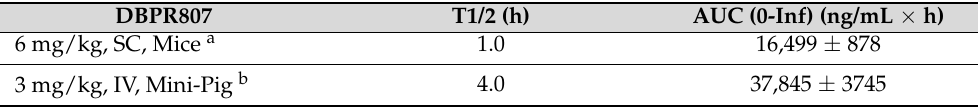
Table 1. Pharmacokinetics of DBPR807 in mice and